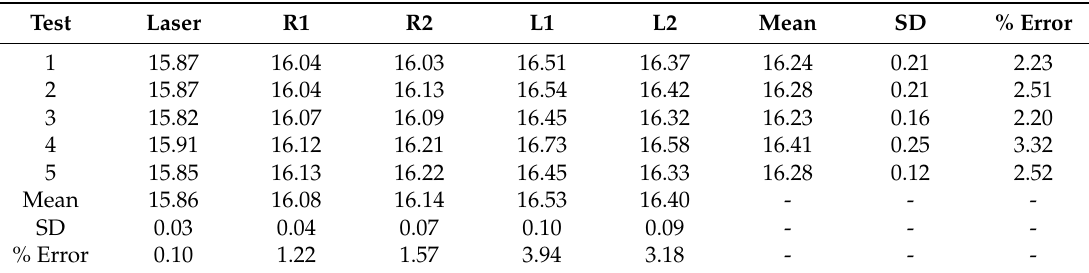
Table 2. Range test, 15.88 m straight line. Comparing the distance found by the laser, the distance found independently for each of the four wheels (R1, R2, L1, L2), and the known distance from the court markings.